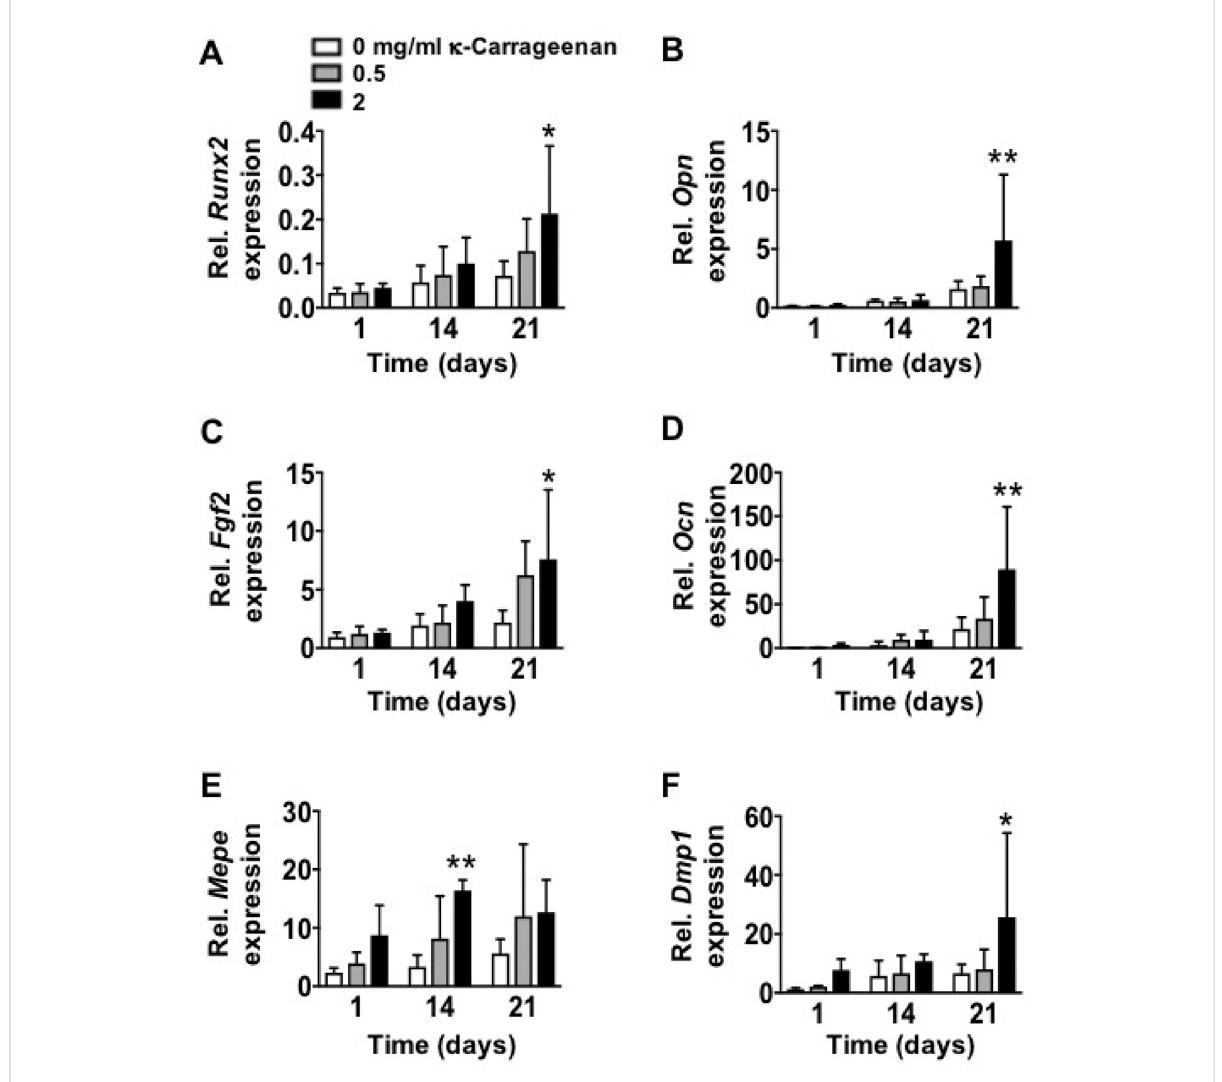
FIGURE 9 Effect of increasing κ -carrageenan concentration in OCP-coating of titanium discs on expression of osteogenic markers in MC3T3-E1 pre- osteoblastsatday1,14,and 21.Expression pattern of (A) Runx2, (B) Opn, (C) Fgf2, (D) Ocn, (E) Mepe, and (F) Dmp1 .Values aremean± SD. n